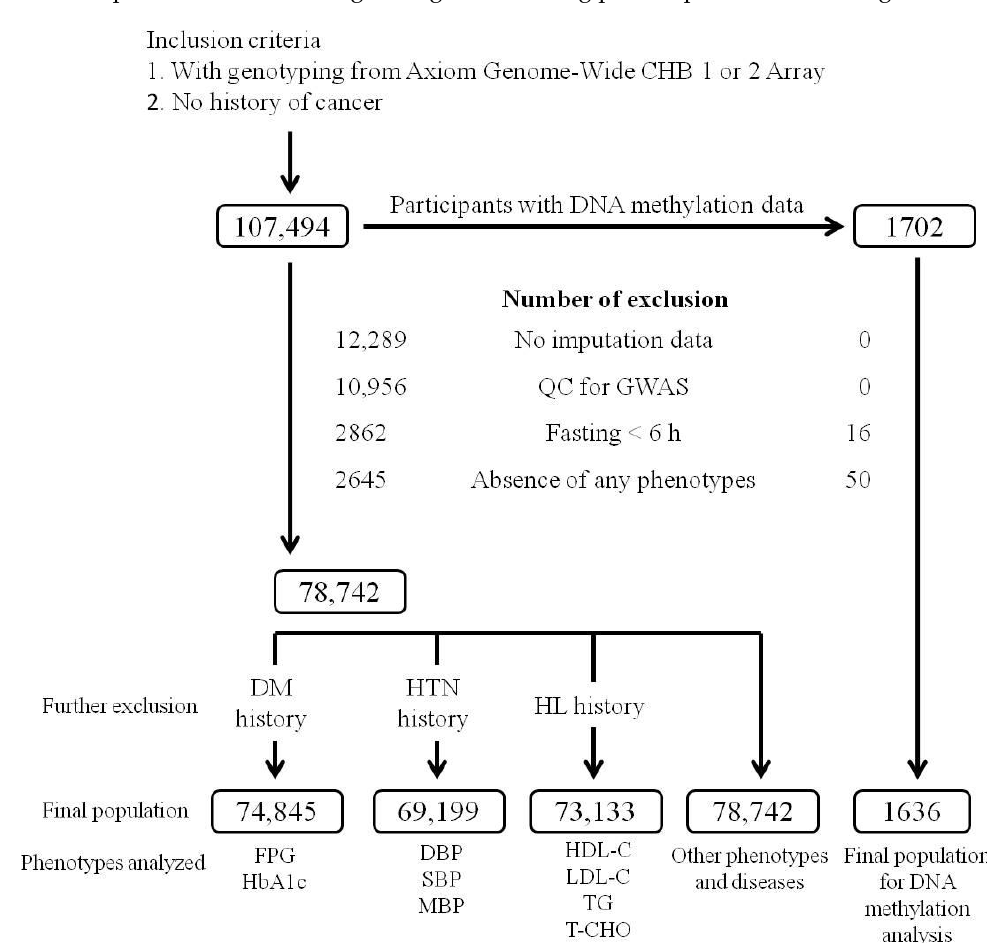
Figure 1. Study inclusion and exclusion criteria flowchart. This flowchart presents the inclusion